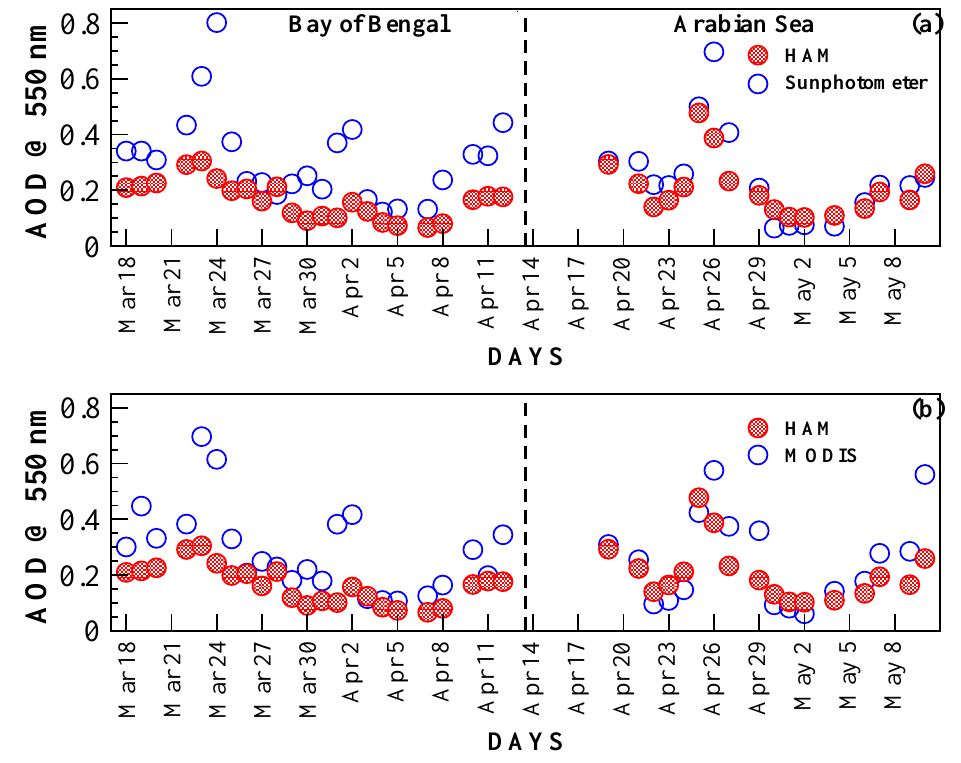
Fig. 1. Comparison of model derived aerosol optical depth (AOD) at 550nm with (a) ship-based remote sensing measurements and (b) MODIS satellite retrievals during the ICARB cruise period from 18 March to 10 May 2006.